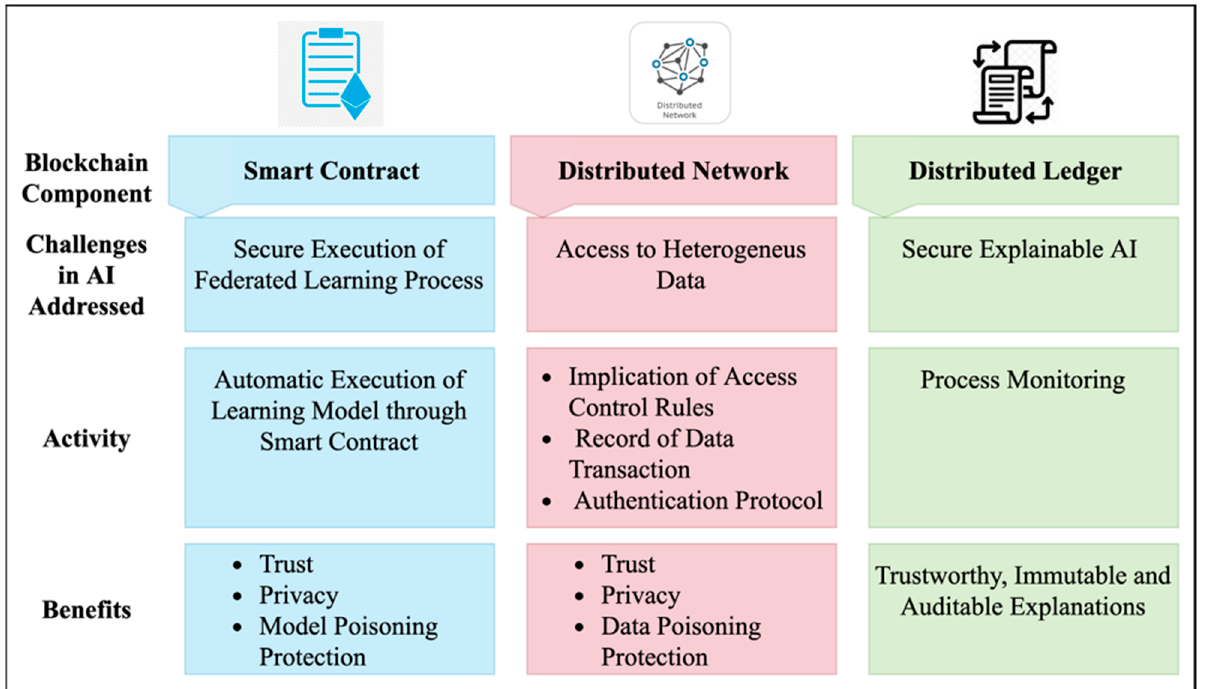
Figure 19. Blockchain solution for challenges in AI.